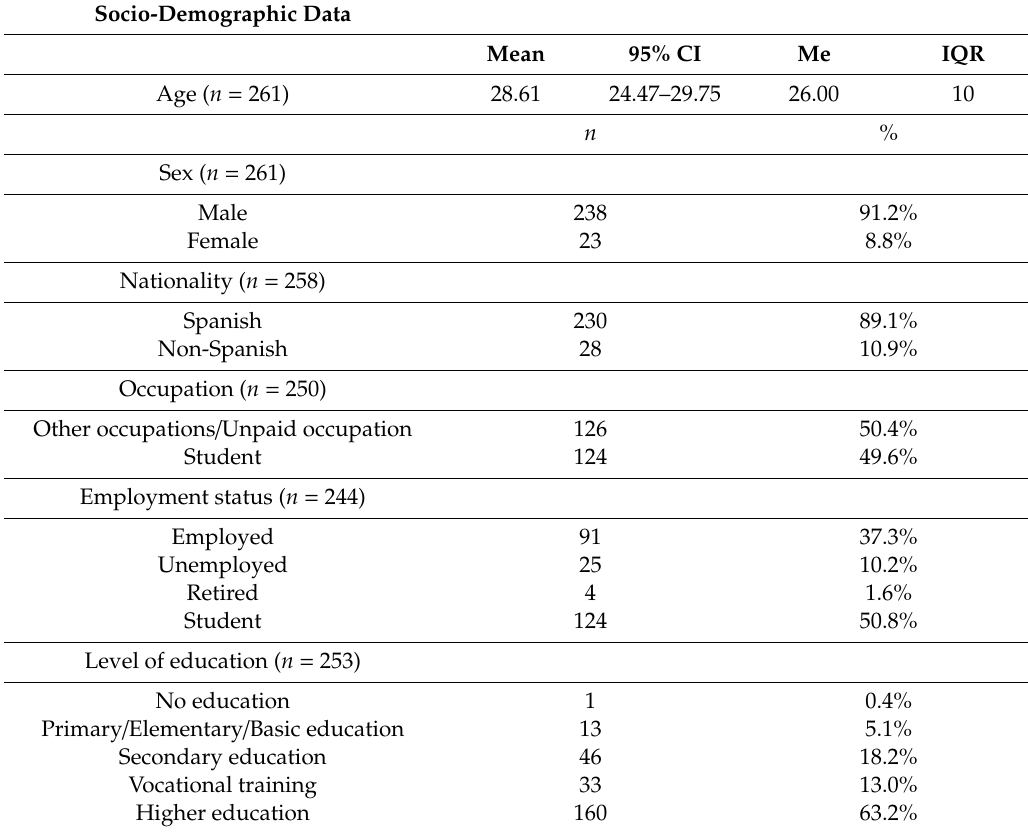
Table 1. Sample Table 1. Sample characteristics.